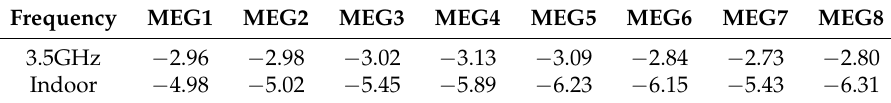
Table 2. Calculated Mean Effective Gain (MEG) values of the MIMO Antenna.